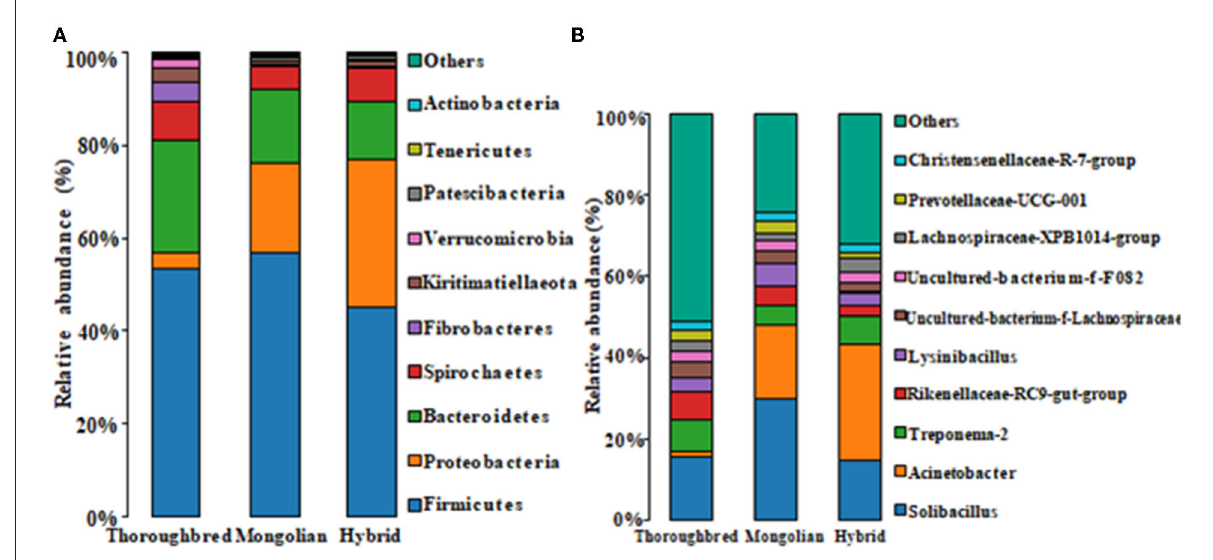
FIGURE4 Species distribution histogram. (A) The top 10 phyla in abundance. (B) The top 10 genera in abundance.